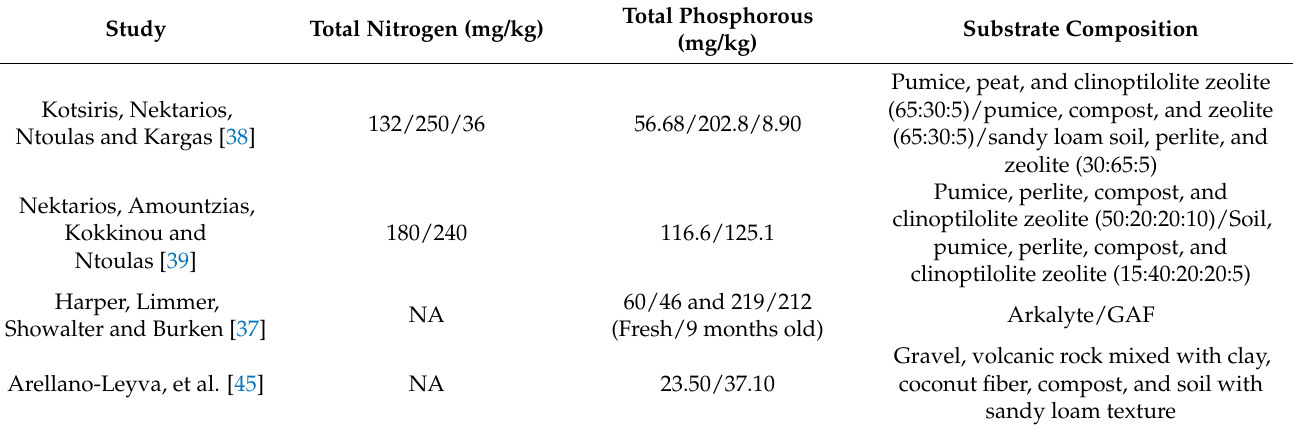
Table 4. Nutritional characteristics of green roof substrates reported in other studies.